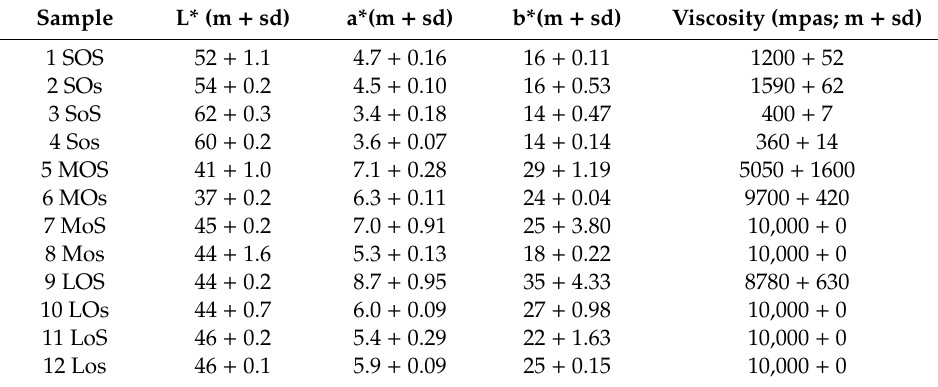
Table 5. Mean values ( ± SD) of L*, a*, b* color space and viscosity of the sample prepared, n = 2. Sample